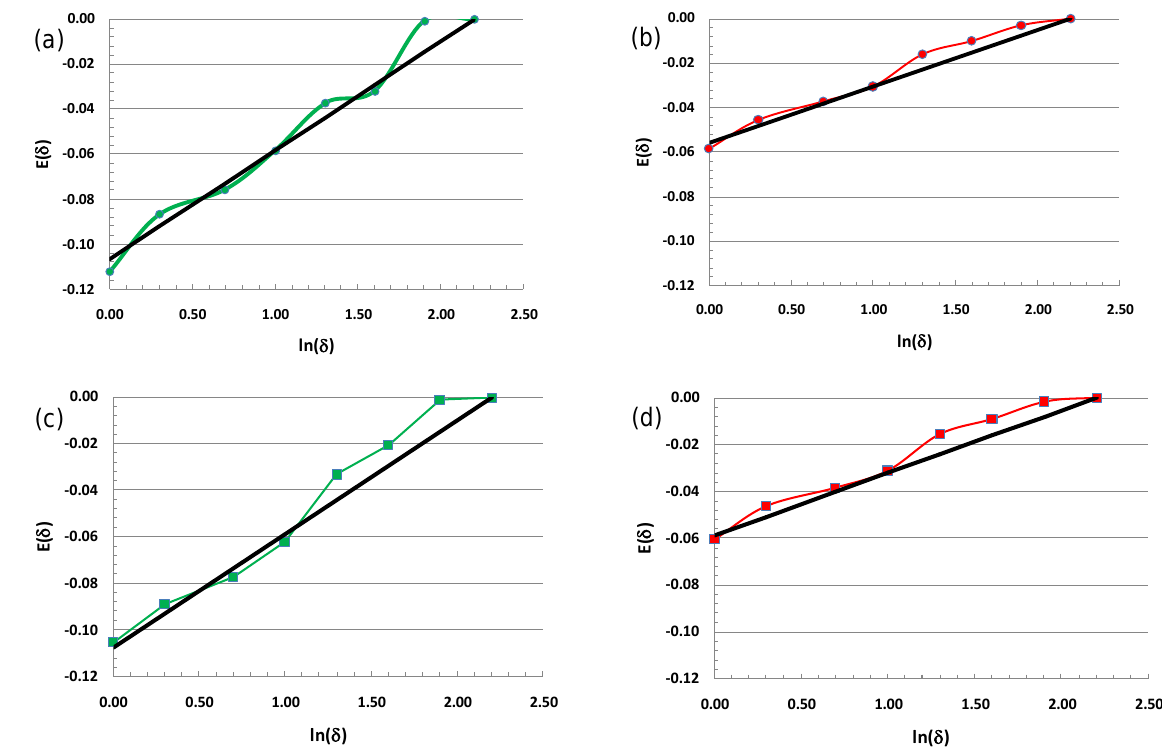
Figure 8. Relative entropy ( E(δ)) with respect to the number of data points ( δ) of (a) grain nitrogen content (GN), (b) grain weight (GW), (c) wheat nitrogen content (PN) and (d) wheat weight (PW). Black lines represent E(δ) based on the entropy dimension ( D 1 ) of each